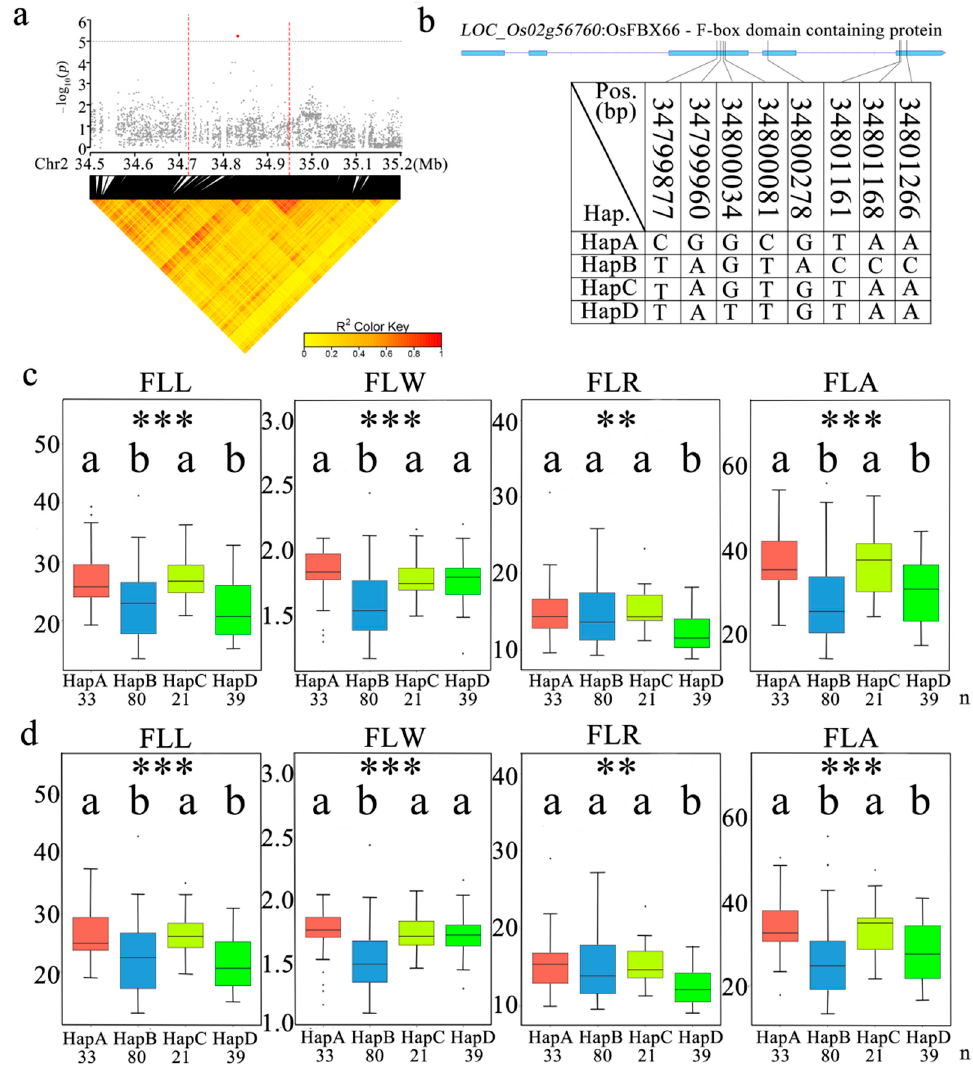
Figure 6. Haplotype analysis of the candidate gene: ( a ) Local Manhattan plot (top) and linkage disequilibrium heatmap (bottom). The candidate region lies between the red solid lines; ( b ) Schematic representation of LOC_Os02g56760 structure and single-nucleotide polymorphisms in LOC_Os02g56760 cDNA between HapA, HapB, HapC, and HapD. Blue boxes indicate exons; ( c ) Box plots for FLL, FLW, FLR, and FLA in the four haplotypes of LOC_Os02g56760 in all accessions in 2019; ( d ) Box plots for FLL, FLW, FLR, and FLA in the four haplotypes of LOC_Os02g56760 in all accessions in 2020. The number of accessions (n) of each haplotype (Hap) in each panel is given under the x -axis. Boxes show the median and upper/lower quartiles. Whiskers extend to 1.5× the inter-quartile range, with any remaining points indicated with dots. **, p < 0.01; ***, p < 0.001 (ANOVA). Letters indicate significant differences, p < 0.05 (Duncan’s multiple comparison test).